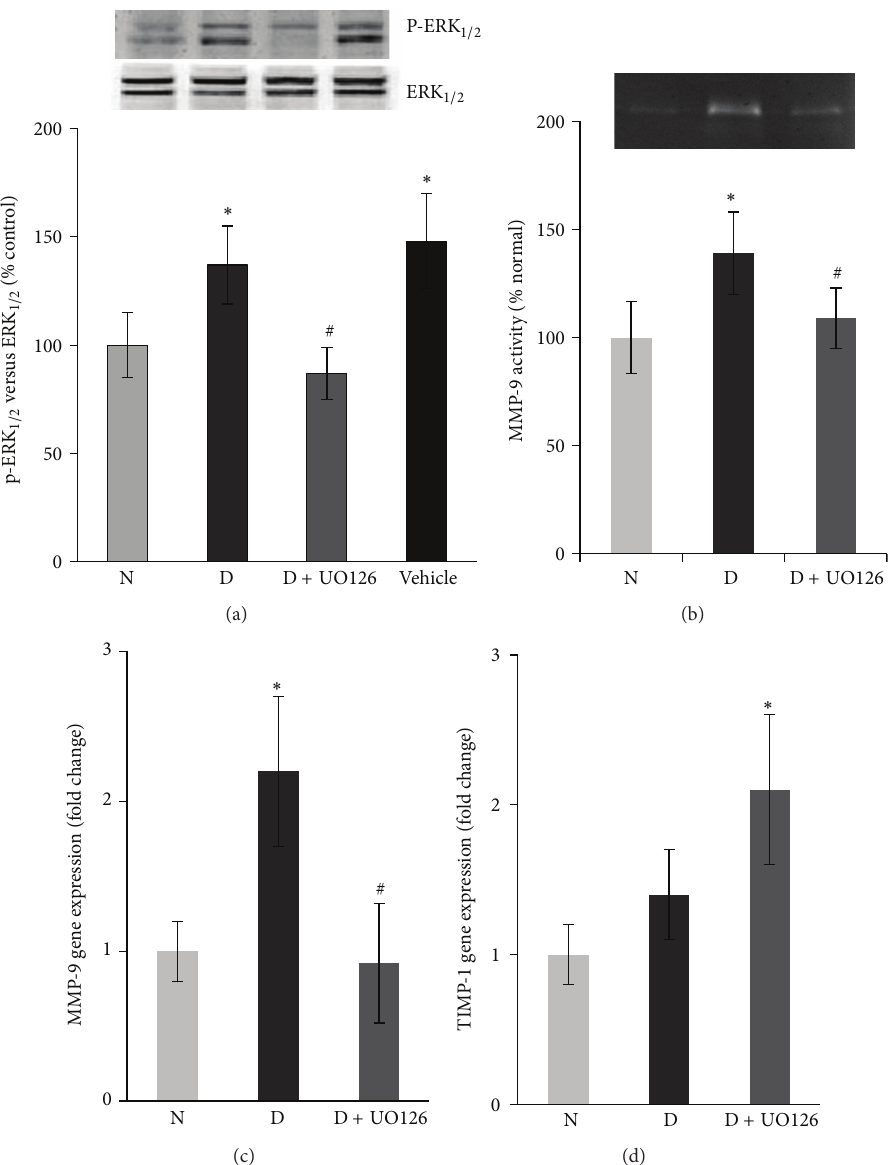
Figure 2: Effect of ERK 1/2 inhibitor (U0126) on diabetes induced retinal ERK 1/2 activation and MMP-9 and TIMP-1 expressions. Protein expressions of ERK 1/2 activation (phosphorylation) were quantified by western blotting using phosphospecific antibody and were adjusted to the protein levels of unphosphorylated antibody in each sample. The expression of (b) MMP-9 gelatinase activity was quantified by using zymography technique. Gene expressions of (c) MMP-9 and (d) TIMP-1 were quantified by RT-PCR using the specific primers and were adjusted to the mRNA levels of 𝛽 -actin in each sample. Each measurement was performed at least three times. Results are expressed as mean ± s.d. of at least six rats in each group. ∗ 𝑃 < 0.05 compared with normal rats and # 𝑃 < 0.05 compared to diabetic rats. N, D, and D + U0126 = normal, 1-week diabetic and U0126 pretreated diabetic